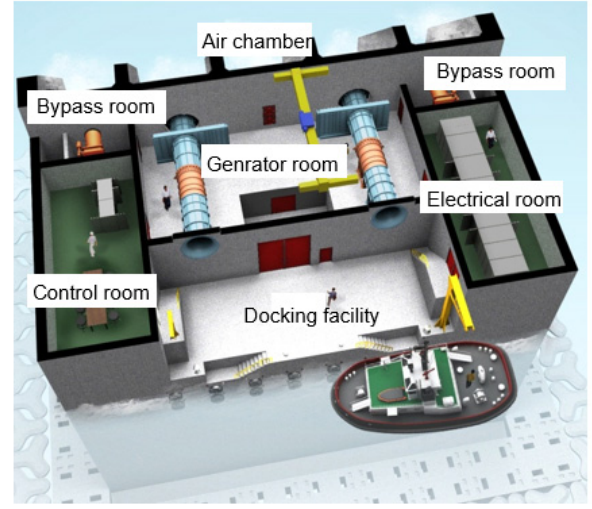
Figure 2. Composition of